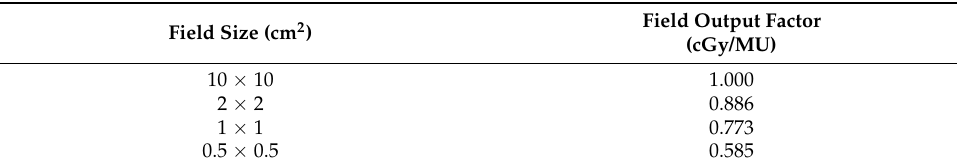
Table 2. Output factors used to determine the calibration curve.